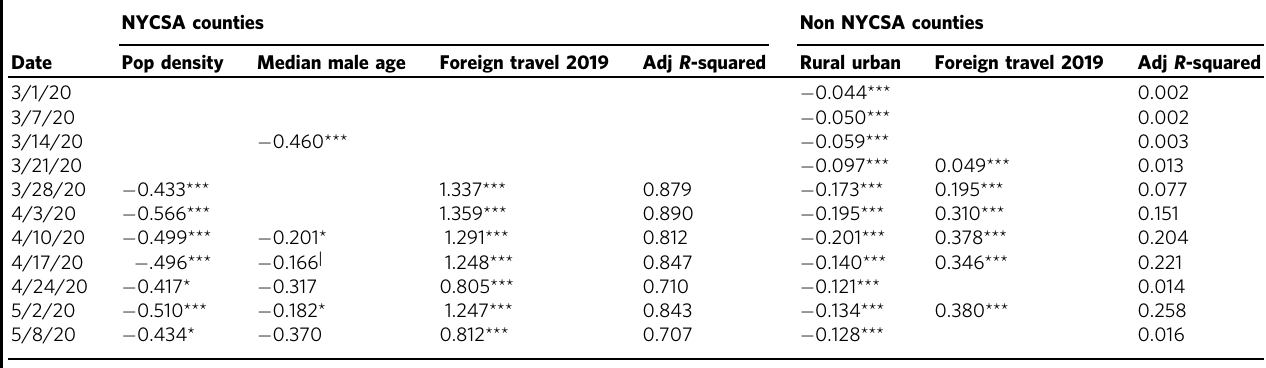
Table 1 Results of per capita COVID-19 deaths raw data models.